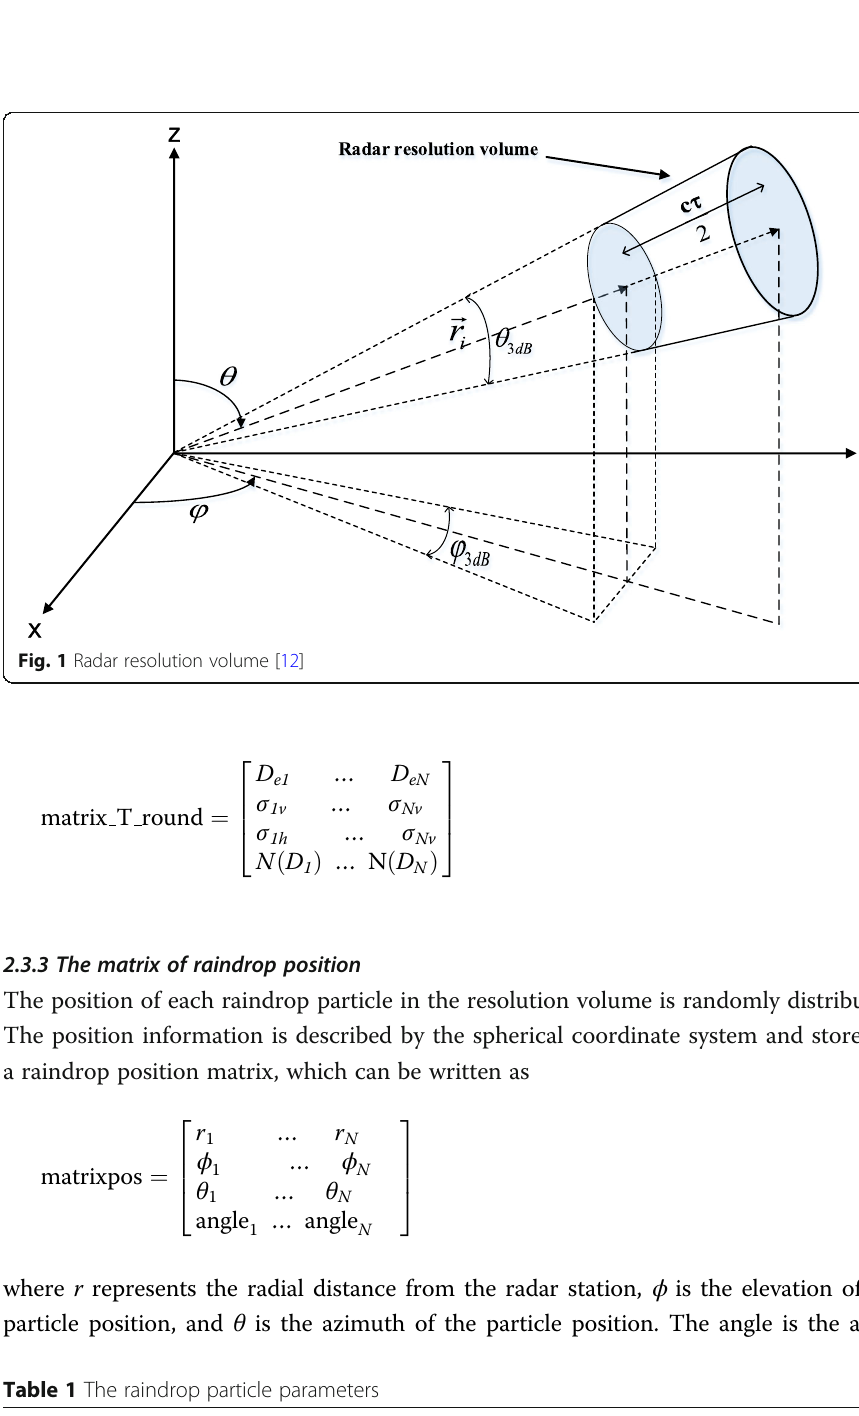
Table 1 The raindrop particle parameters Parameter Value Minimum particle diameter (mm) 0.01 Boundary diameter of small and medium particles (mm) 0.5 Boundary diameter of large and medium particles (mm) 3 Maximum particle diameter (mm)